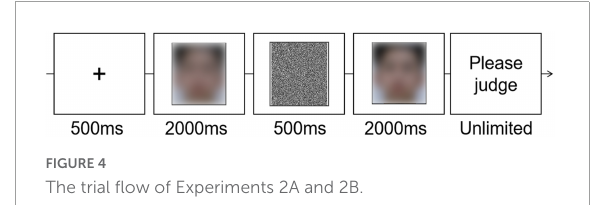
FIGURE4 The trial flow of Experiments 2A and